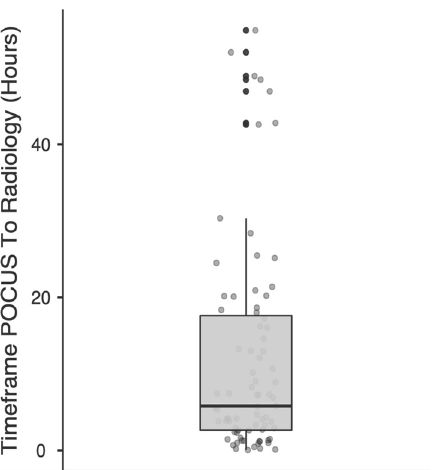
Figure 3. Scattergram of the timeframe of POCUS to definitive radiology